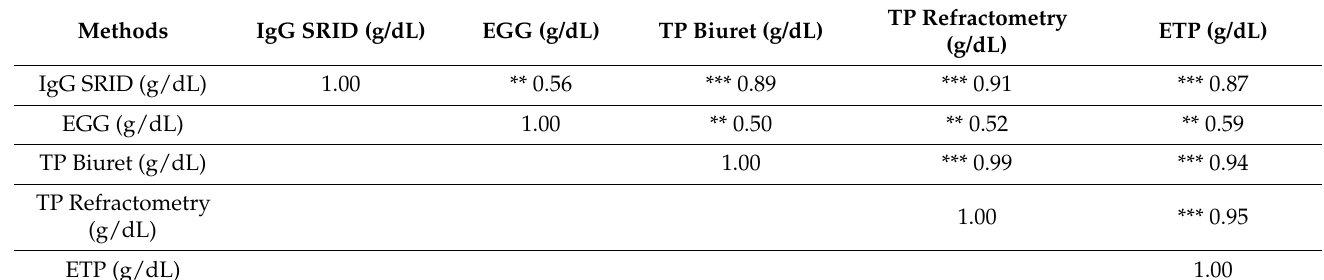
Table 2. Values concerning the coefficient of correlation between different methods for the evaluation of immunoglobulins type G and serum total protein in a population of nine donkeys. Legend: IgG—immunoglobulin type G; SRID—serum radial immunodiffusion; EGG—electrophoresis gamma globulin; TP—total protein; ETP—electrophoresis total protein; ** = p -value between 0.01 and 0.001; *** = p -value < 0.001.